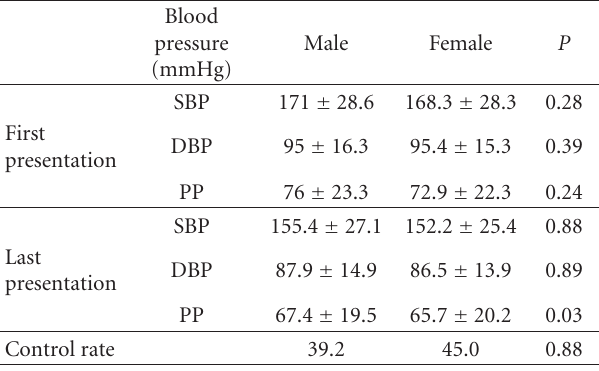
Table 4: Change in blood pressure by